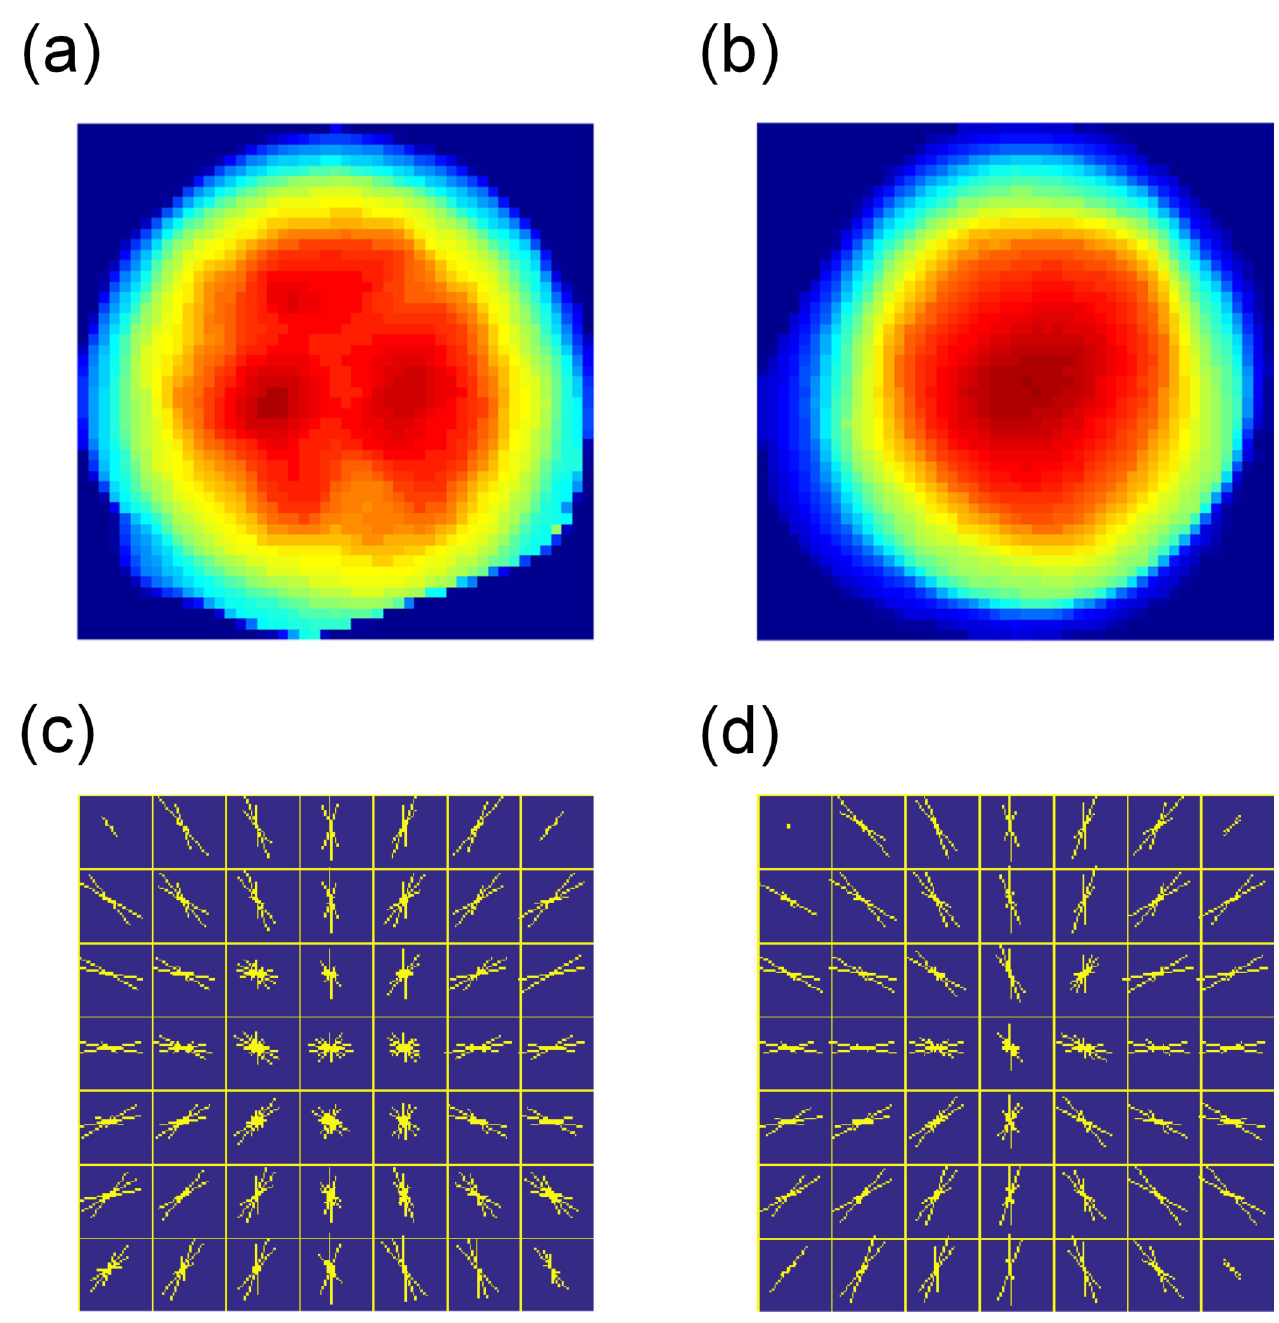
Fig 5. Representative QPM images and their visualized HOG features. (a) QPM image of cell line. (b) QPM image of WBC. In (a) and (b), pseudo color represents OPL. OPL is not normalized by diameter or path length. (c) Visualized HOG feature of (a). (d) Visualized HOG feature of (b). In (c) and (d), angles and lengths of the yellow lines in each compartment respectively represent orientation and strength of spatial gradient in OPL of the image.